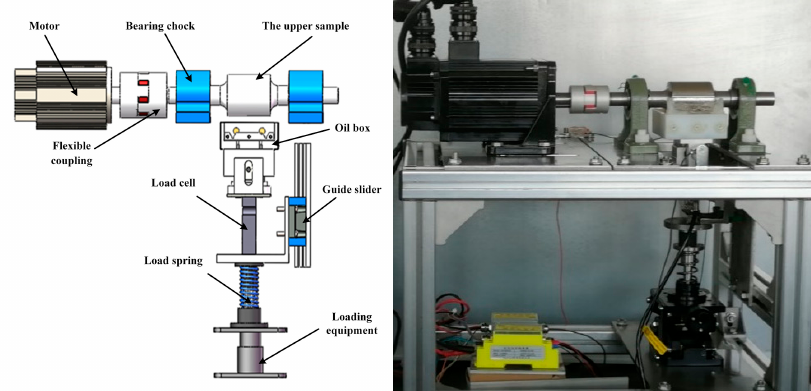
Figure 1. Schematic diagram of double-point contact friction test machine.